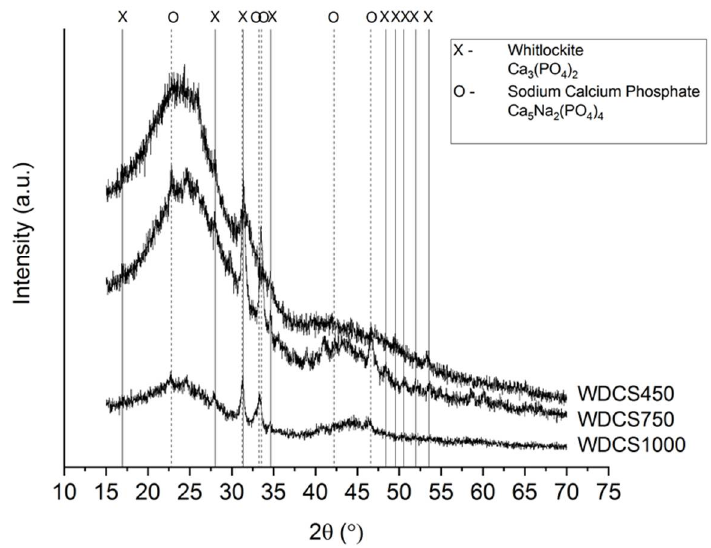
Figure 4. XRD diffractograms of the whey-carbon scaffolds.